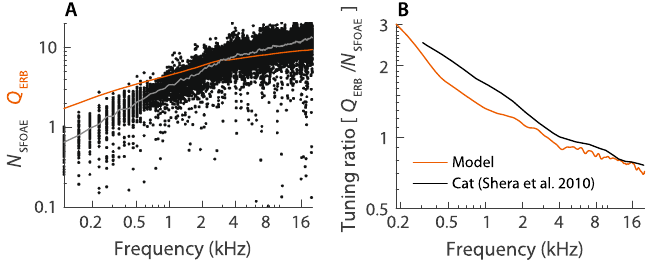
Figure 4. ( A ) Model SFOAE delays N SFOAE . Dots indicate individual simulations and the gray line represents their median at each frequency. For comparison, the red line plots Q ERB from Fig. 3D at the corresponding CFs. SFOAEs were simulated in 128 different “ears” by introducing small random irregularities in the partition admittance [methods detailed in 23 ]. ( B ) Comparison between the model tuning ratio ( Q ERB / N SFOAE ) and that obtained from otoacoustic and neural data in cat (Fig. 9 of Ref.